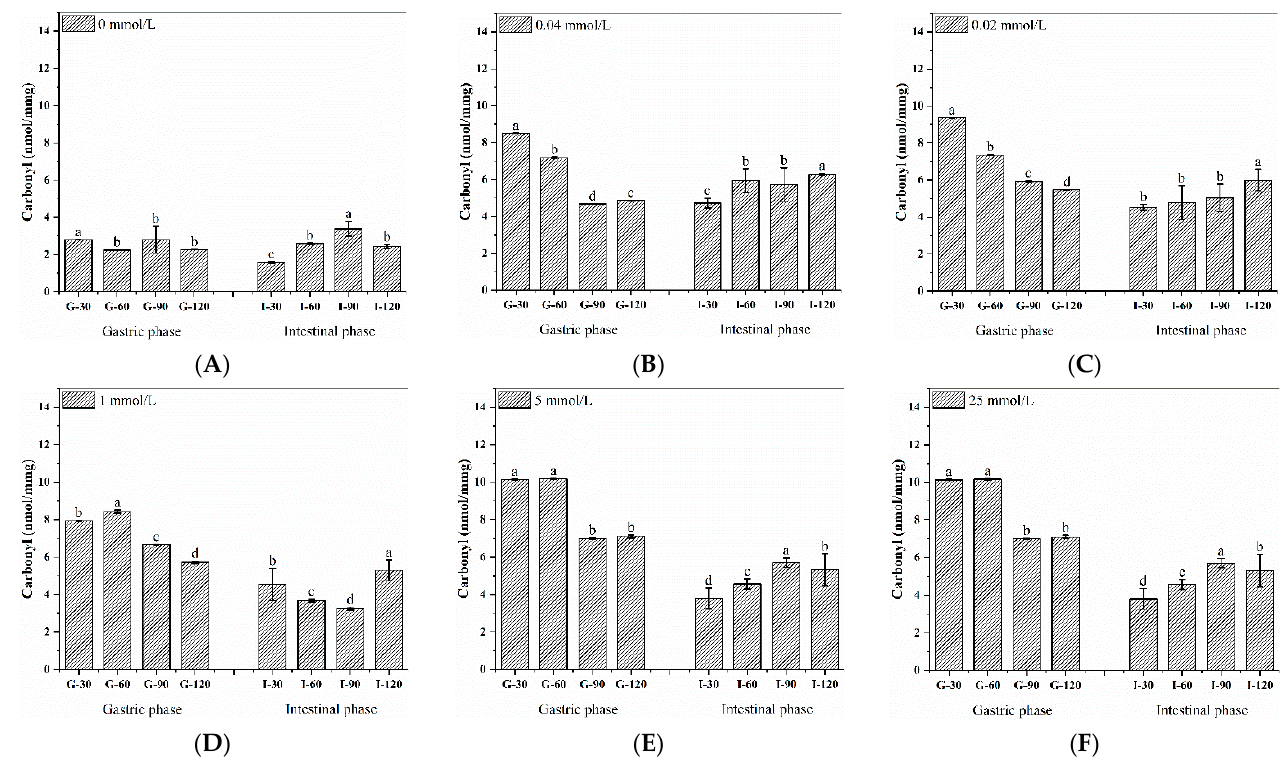
Figure 3. Carbonyl content of walnut isolated proteins after AAPH oxidation in the process of gastric and subsequent intestinal digestion at 30, 60, 90, and 120 min, respectively. ( A – F ) represent different incubation concentrations of AAPH, and different letters (a–d) indicate significant differences at p < 0.05.